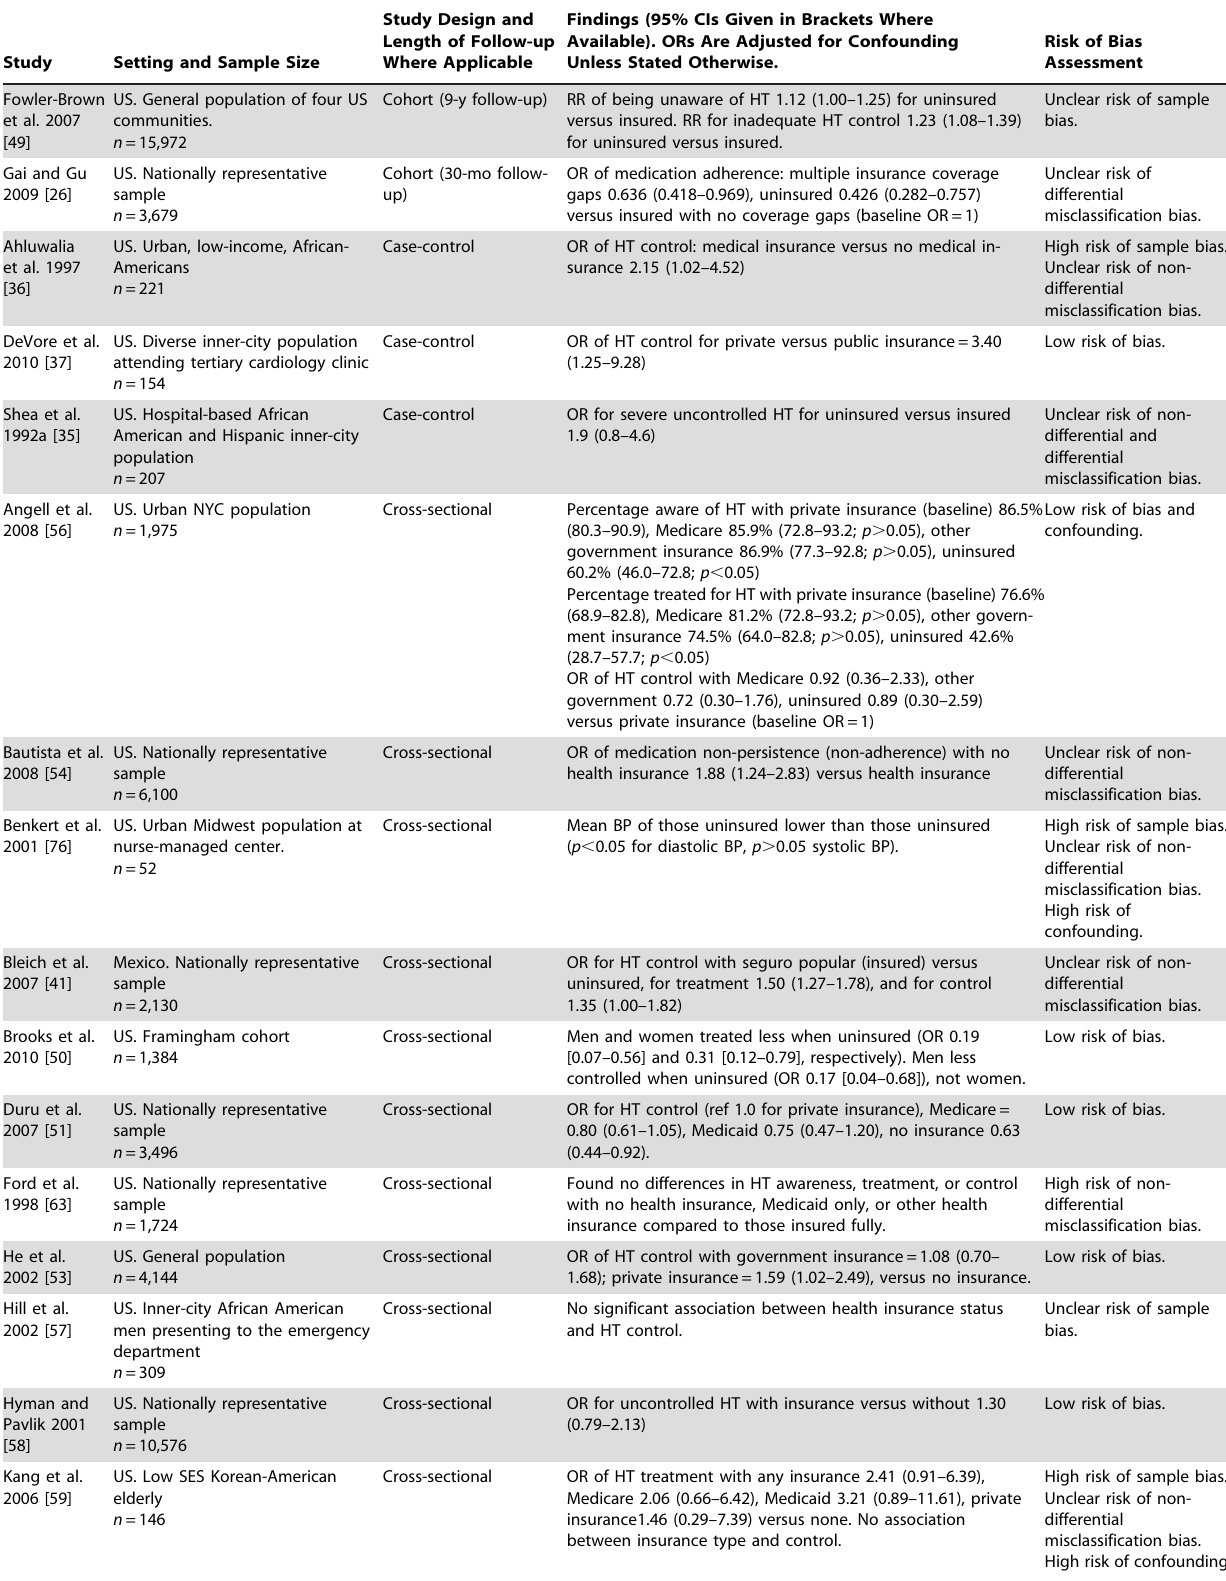
Table 3. Findings of quantitative studies examining the association of health insurance status with hypertension